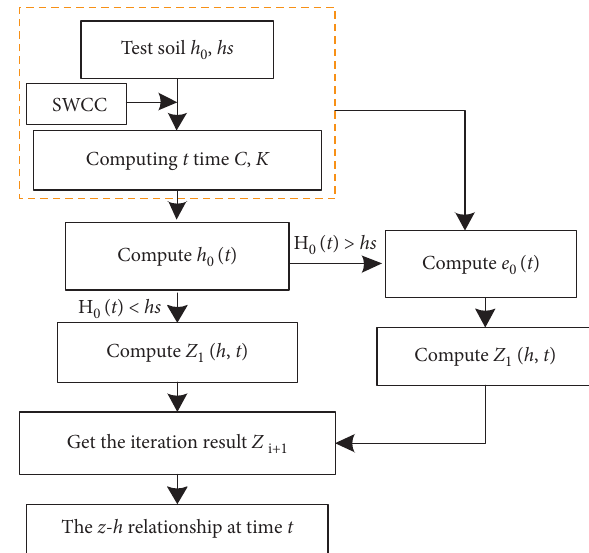
Figure 5: Flow chart off ice-snow melting infiltration iterative